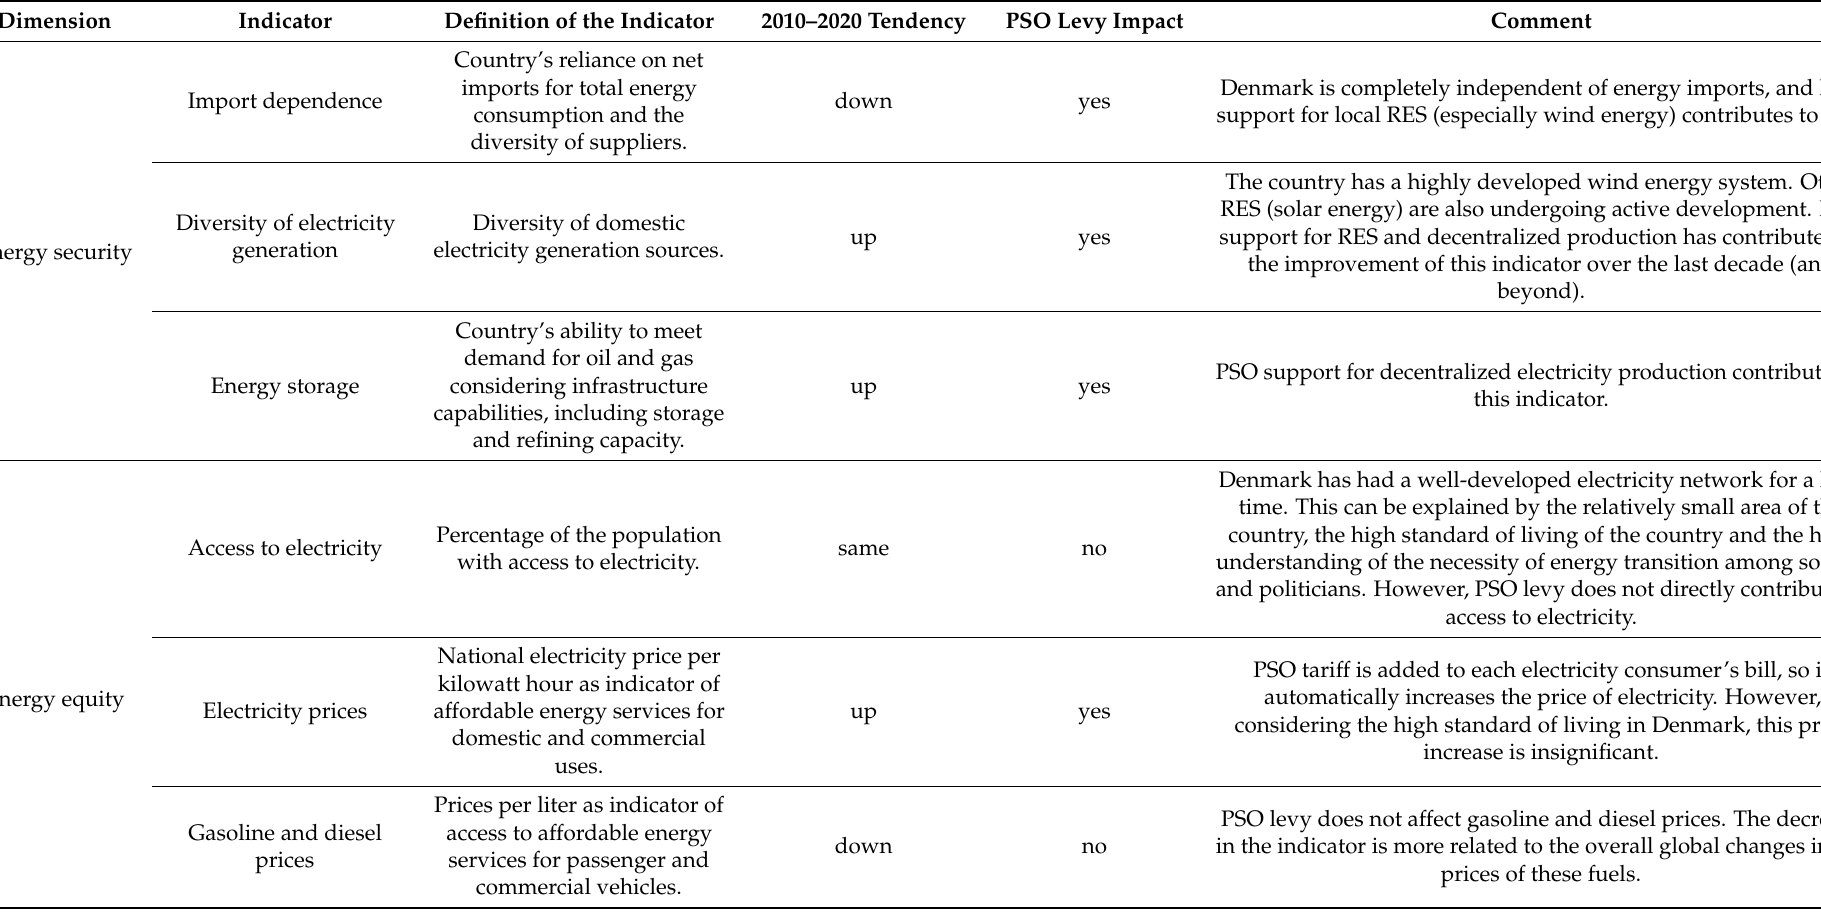
Table 5. PSO levy impact on Energy Trilemma Index for Denmark (designed by the authors, based on